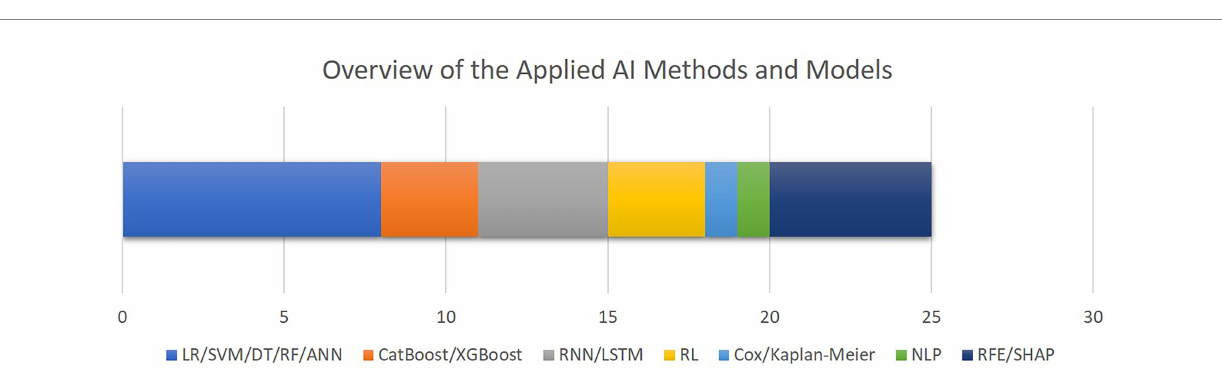
FIGURE 6 The overview of the AI methods and models applied for outcome prediction or interpretability. The bar chart shows how frequent each AI method has been, with the X axis quantifying the number of studies. Note that some studies applied multiple algorithms or methods (LR, logistic regression; SVM, support vector machine; DT, decision trees; RF, random forest; ANN, artificial neural networks; CatBoos, categorical boosting; XGBoost, extreme gradient boosting; RNN, recurrent neural networks; LSTM, long short-term memory; RL, reinforcement learning; NLP, natural language processing; RFE, recursive feature elimination; SHAP, SHapley Additive exPlanations).